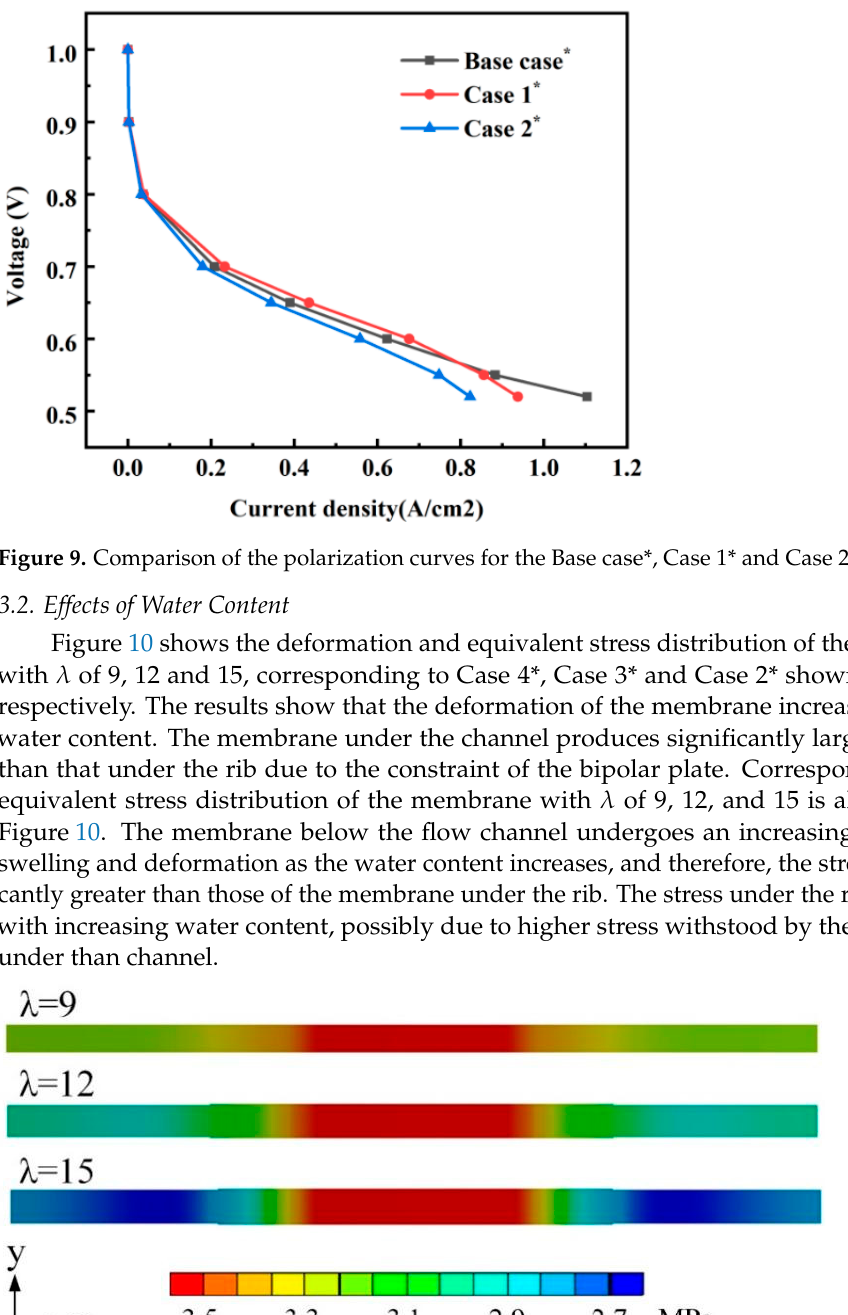
Figure 10. Deformation and equivalent stress distribution of membrane with water content of 9, 12 and 15, corresponding to Case 4*, Case 3* and Case 2* shown in Table 1, respectively. Figure 11 shows the distribution of oxygen mass fraction near the cathode inlet (z = 5 mm) for Case 2*, Case 3* and Case 4* at the operating voltage of 0.6 V. Figure 12 shows the distribution of liquid water volume fraction in the same plane. For these three cases, the magnitude of the oxygen mass fraction in the GDL is: Case 2* > Case 4* > Case 3*; and reversely, the magnitude of the volume fraction of liquid water in the GDL region under the flow channel is: Case 3* > Case 4* > Case 2*. The compression of the GDL